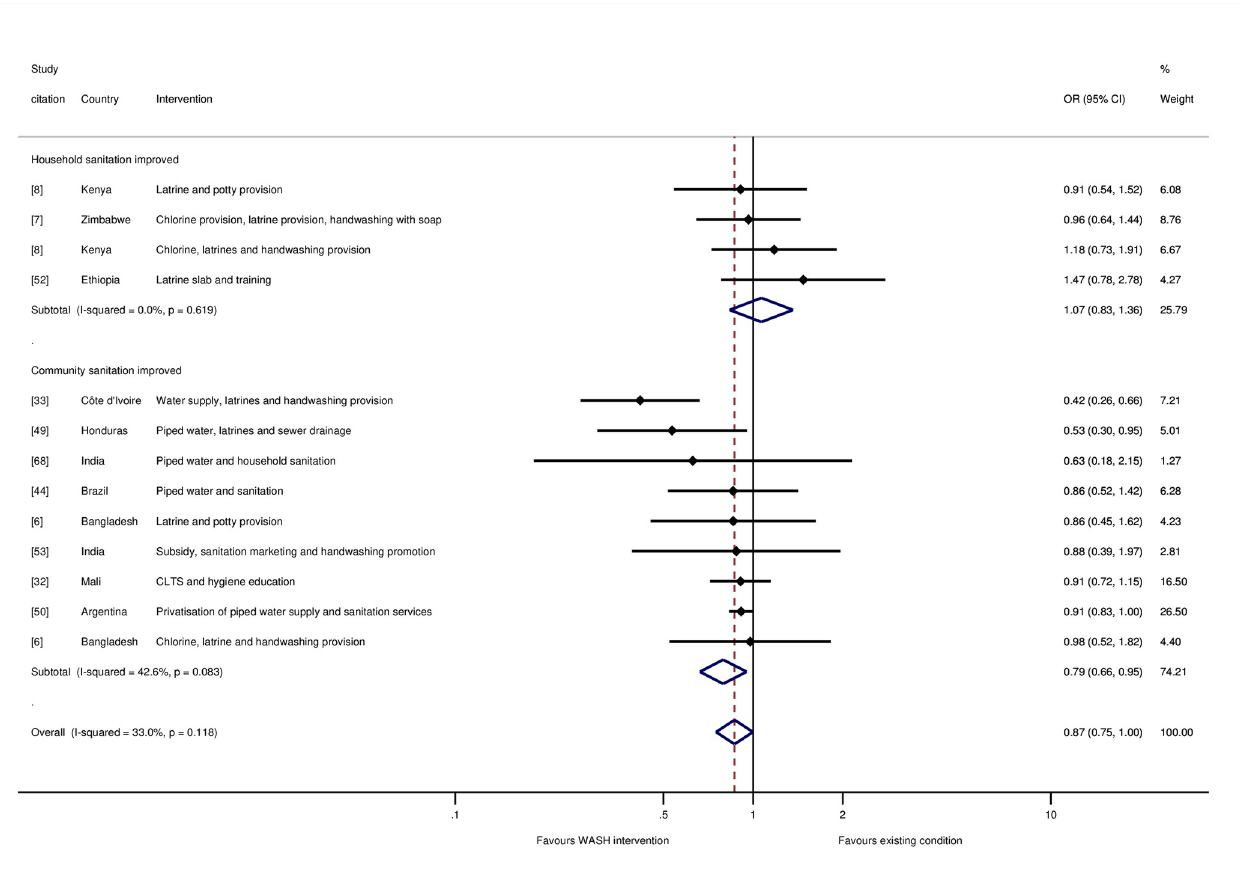
Fig 6. Effects on all-cause mortality in childhood of sanitation